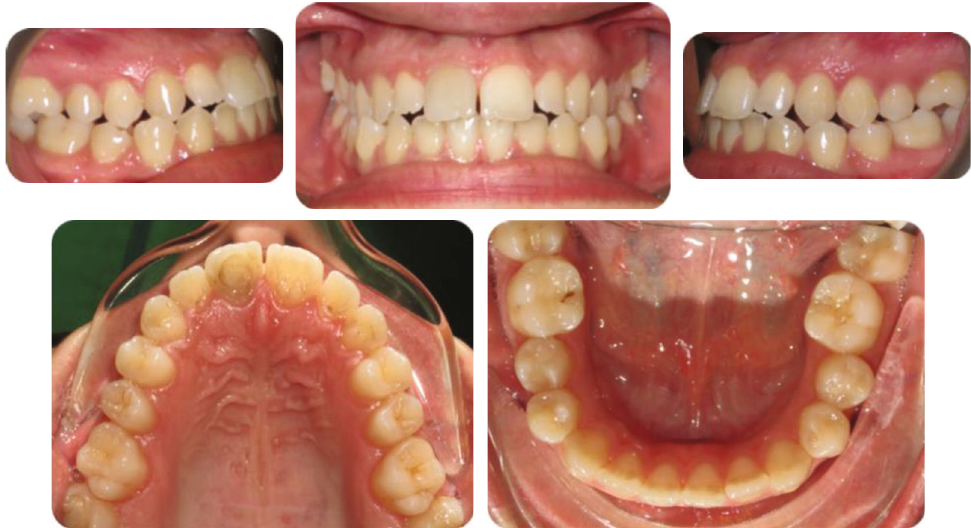
Figure 2: Pretreatment intraoral photographs.